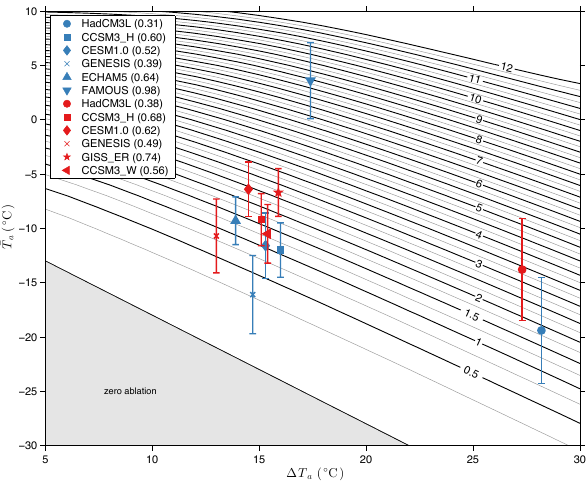
Fig. 8. Contours show potential snowmelt ( ˆ a s , m yr − 1 ) for differ- ent values for the annual mean air temperature ( ¯ T a ) and annual air temperature half range ( ∆ T a ). If the total annual precipitation ex- ceeds this amount then snow will accumulate. Also shown are the values for ¯ T a and ∆ T a from the GCM simulations, averaged over the mountainous regions ( > 1500 m) and lapse rate corrected. Error bars for ¯ T a are 1 standard deviation of ¯ T a above 1500 m. The mean precipitation over mountainous regions is included in parenthesis in the legend (m yr − 1 ). 2 × PIC simulations shown in blue and 4 × PIC simulations shown in red.